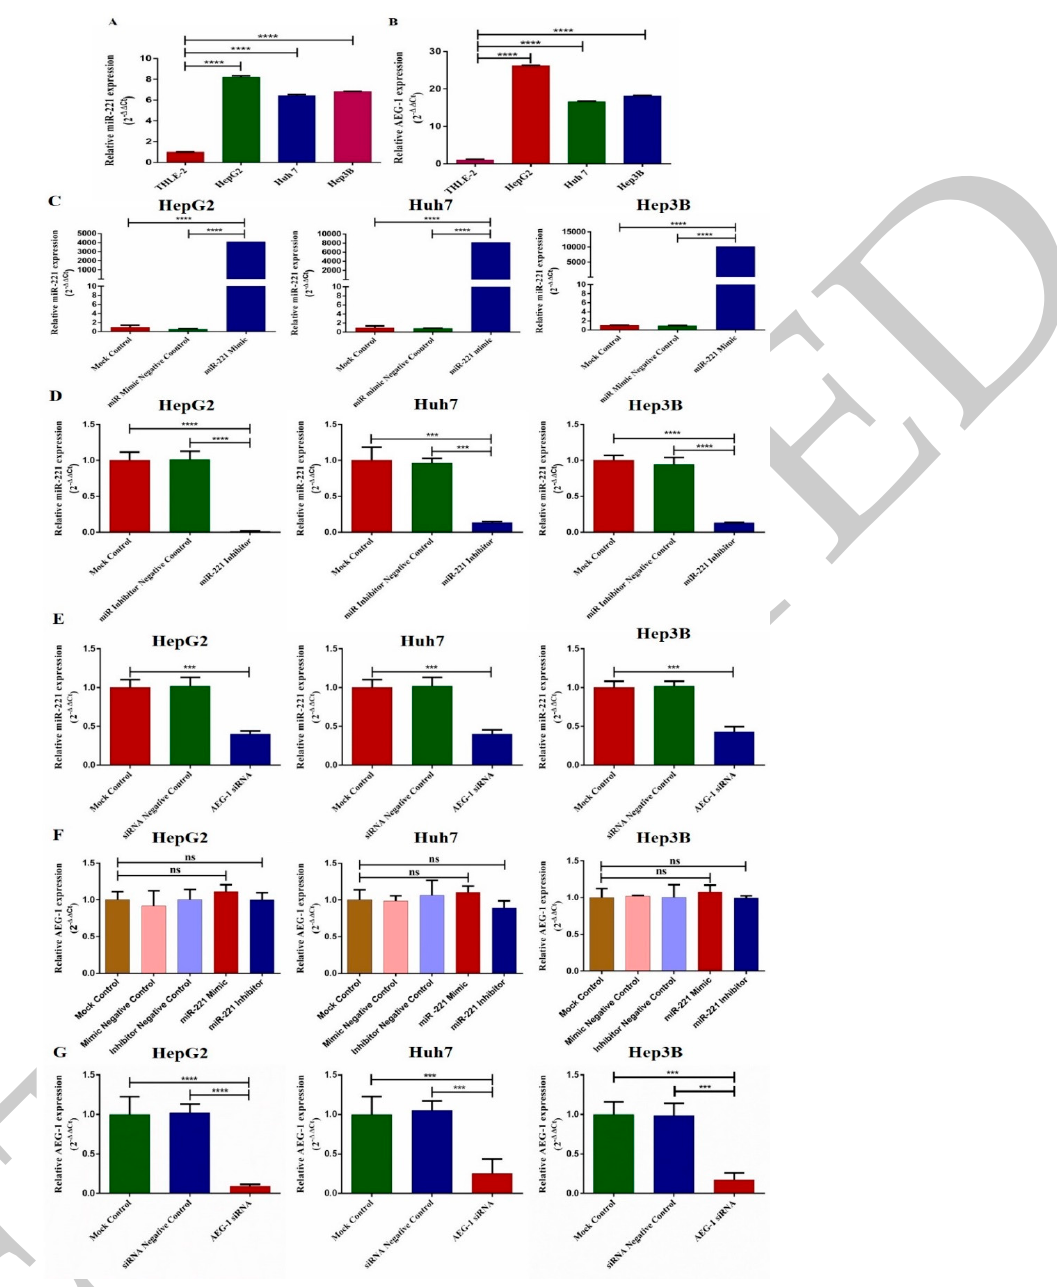
Figure 1. Relative mRNA expression levels of miR-221 and AEG-1 in normal liver and HCC cell lines. Relative mRNA expression of miR-221 ( A ) and AEG-1 ( B ) was analyzed in normal liver and HCC cell lines, the expression of miR-221 in miR-221 mimic ( C ) and miR-221inhibitor ( D ) and AEG-1 siRNA ( E ) transfected HCC cells. Relative expression of AEG-1 in miR-221 mimic, miR-221 inhibitor and their control ( F ), AEG-1 siRNA and their controls transfected HCC cells ( G ). All mRNA expressions were performed using qRT-PCR. mRNA expressions were normalized using RNU6 and GAPDH. All reactions were performed in triplicates. Error bars are presented as mean ± s.d. and *** p < 0.001, **** p < 0.0001. ns: non-significance.